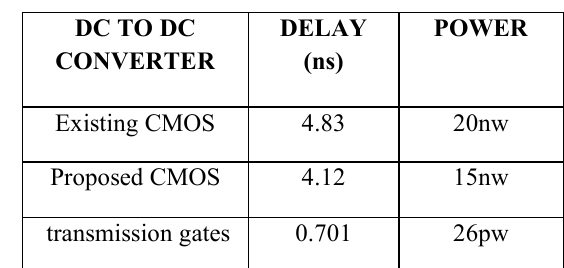
Table 2. Comparison between existing and proposed DC to DC converter circuit.